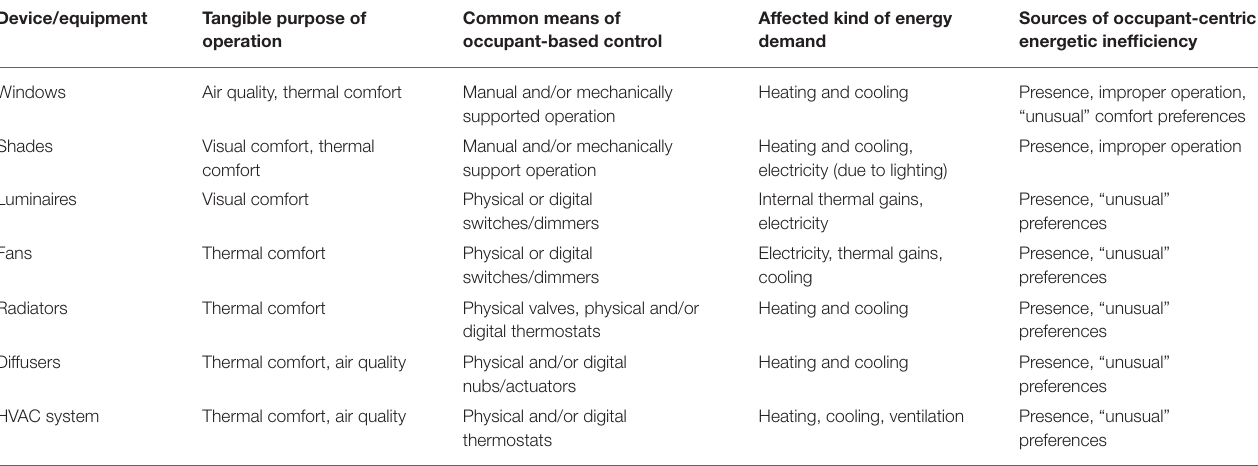
TABLE 1 | Summary representation of buildings’ control devices with associated functionality, interface, relevant energy demand categories, and sources of inefficient operation.